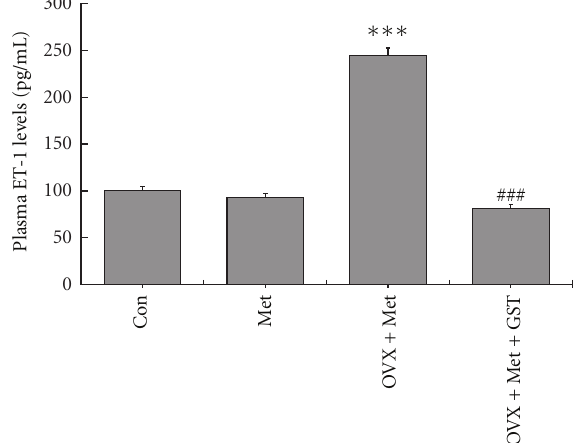
Figure 6: Alterations of plasma ET-1 levels after 12 wk di ff erent treatment. There was a significant increase of plasma ET-1 levels in ovariectomized HHcy rats. Supplementation with genistein could significantly lower the elevated Hcy levels. The results shown are mean ± SEM, n = 8. P values were obtained by one-way ANOVA analysis. ∗∗∗ P < 0 . 001 versus Met; ### P < 0 . 001 versus OVX +